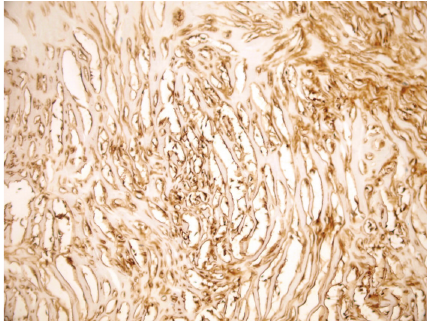
Figure 5: Diffuse CD34 staining in spindle cells (CD34 ×